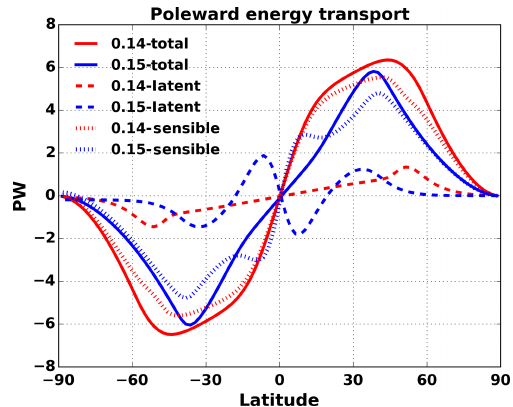
Figure 5. Annual mean behaviour of northward transport of to- tal, latent, and sensible energy in petawatts (PW) for the two terra- planet states in the simulations Z14 and Z15 averaged over a period of 10